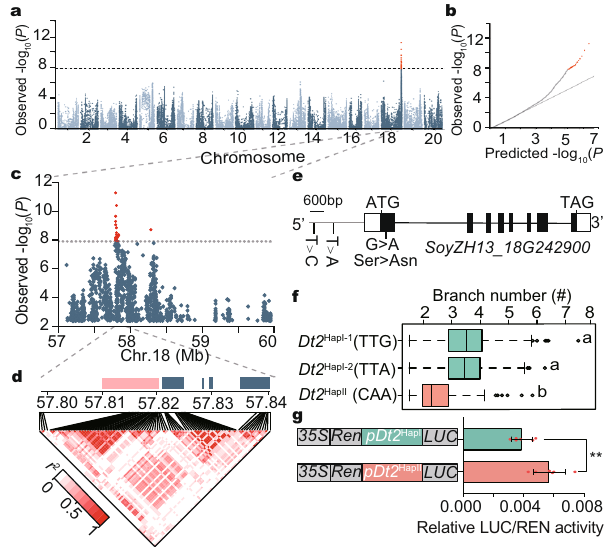
Fig. 1 | GWAS of branch number and haplotype analysis of Dt2 in soybean. a Manhattan plot of GWAS for branch number using 2 years of Blup data of the 2409accessions. P valuesarecalculatedbasedonlinearmixedmodelinGWASand the dashed horizontal line indicates the genome-wide signi fi cance threshold ( P =1×10 − 7.9 ), which is determined by the Bonferroni test. − log 10 P values are plotted against the position of SNPs on 20 chromosomes. b Quantile-quantile plot for the branch number. For quantile-quantile plot, − log 10 -transformed observed P values areplottedagainst − log 10 -transformedexpected P values. c Genome-wide Manhattan plot in the 57 – 60Mb region on chromosome 18. The red lead SNPs are shown above the threshold signals. d Linkage disequilibrium plot for SNPs in the 57.80 – 57.84Mbregionfromacontinuousassociationblock.Navybluebox,genes. Pink box, candidate gene Dt2 . Asterisk, position of the peak SNP. The color key (white to red) represents linkage disequilibrium value ( r 2 ) accessions. e Gene structure of Dt2 . Two SNPs ( − 3259th T>C, − 2580th T>A) in the promoter and a nonsynonymousSNP(+98thG>A)inthe fi rstexonarelabeledonthegenesketch. f Haplotype analysis of Dt2 HapI-1 ( n =1052 accessions), Dt2 HapI-2 ( n =262 accessions) and Dt2 HapII ( n =179 accessions). In each box plot (drawn by R 4.1.1 software), the center line indicates the median, the edges of the box represent the fi rst and third quartiles, and the whiskersextend to spana 1.5 interquartile range from the edges. Different letters indicate statistically signi fi cant differences at P <0.05 by one-way ANOVA test. g Promoter activity analysis of Dt2 HapI and Dt2 HapII using sequences 3,400-bp upstream from the translation initiation site ( n =5 biologically indepen- dent replicates), ** P <0.01, two-sided t -test, and P =6.0×10 − 3 . Data in ( f , g ) are the mean±SEM. Source data are provided as a Source Data fi